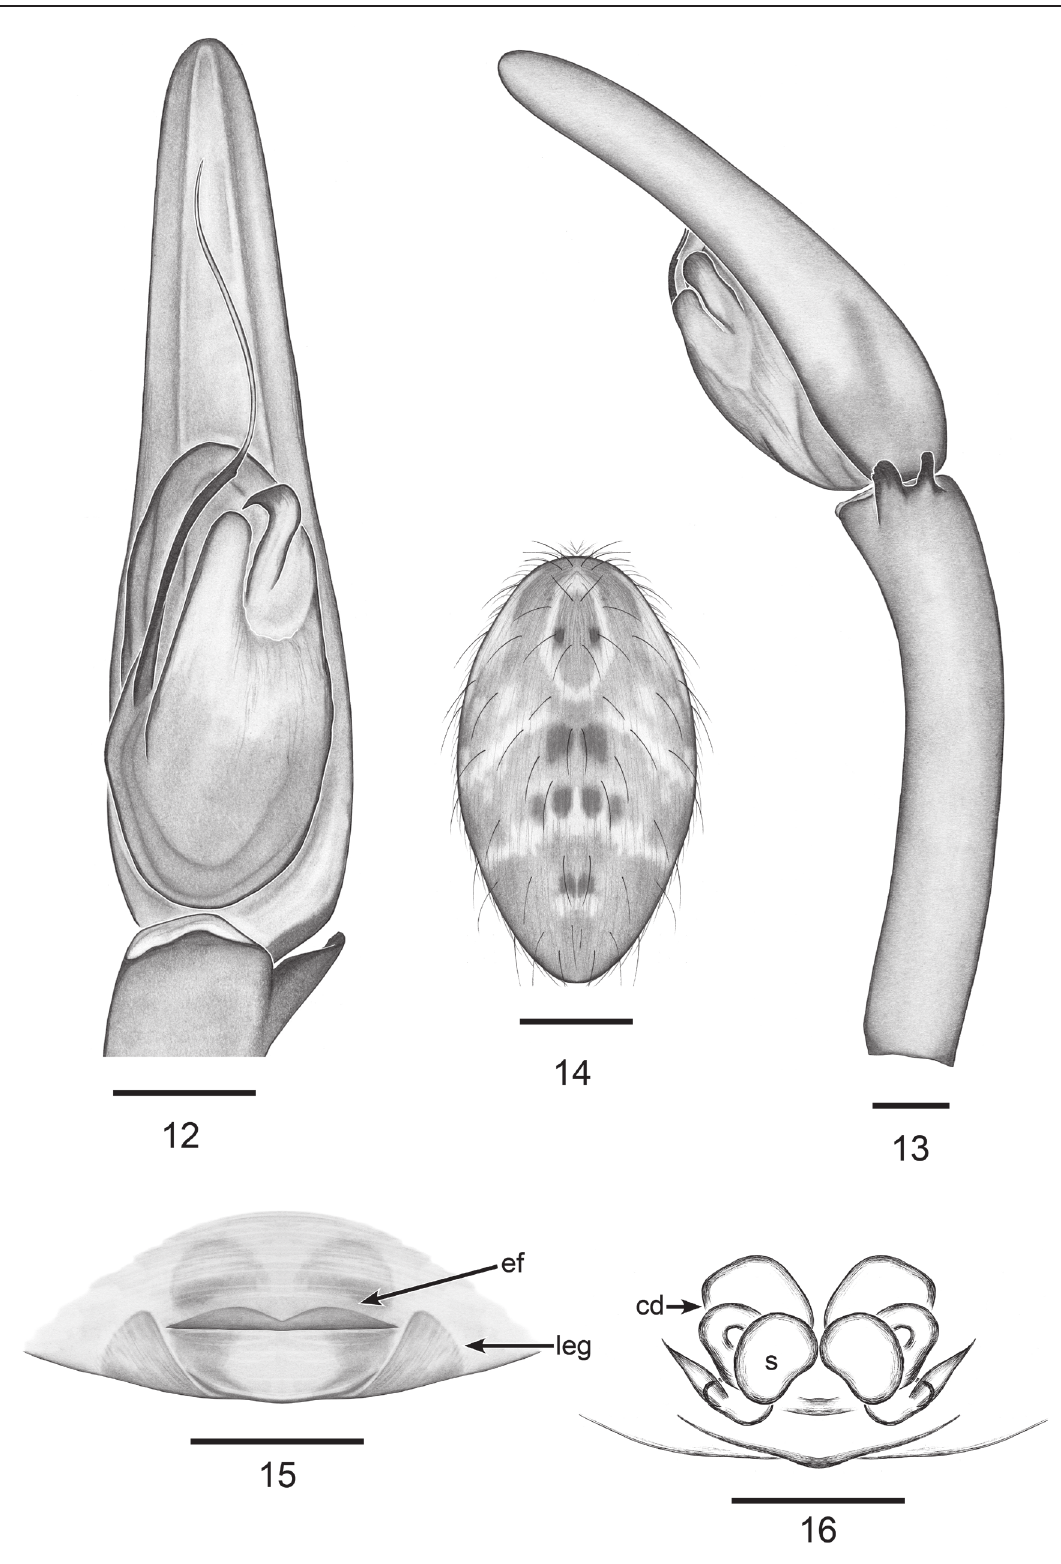
Figs 12–16. Katissa tamya sp. nov. 12 . ♂, palp, ventral view. 13 . ♂, palp, retrolateral view. 14 . ♀, abdomen, dorsal view. 15 . ♀, epigynum, ventral view. 16 . ♀, internal genitalia, dorsal view. Scale bars: 12–13, 15–16 = 0.1 mm; 14 =